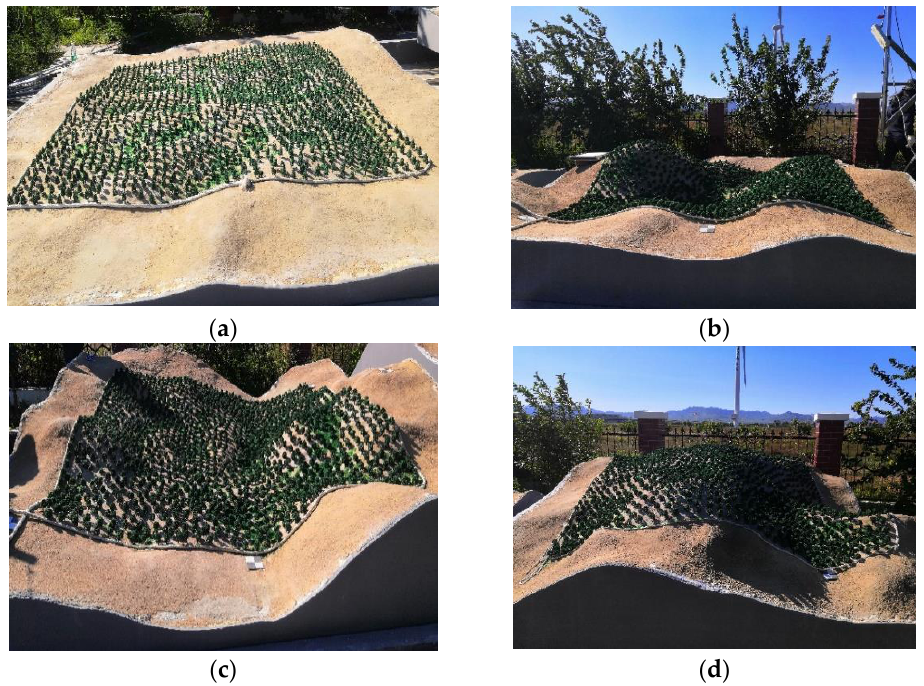
Figure 3. Four typical terrain sandboxes (( a , b ) are both normally distributed terrains. Their mean slopes are 8.4° and 24.7°, respectively; ( c ) is a concave valley with an average slope of 25.7°; and ( d ) is a convex ridge with an average slope of 30.36°).